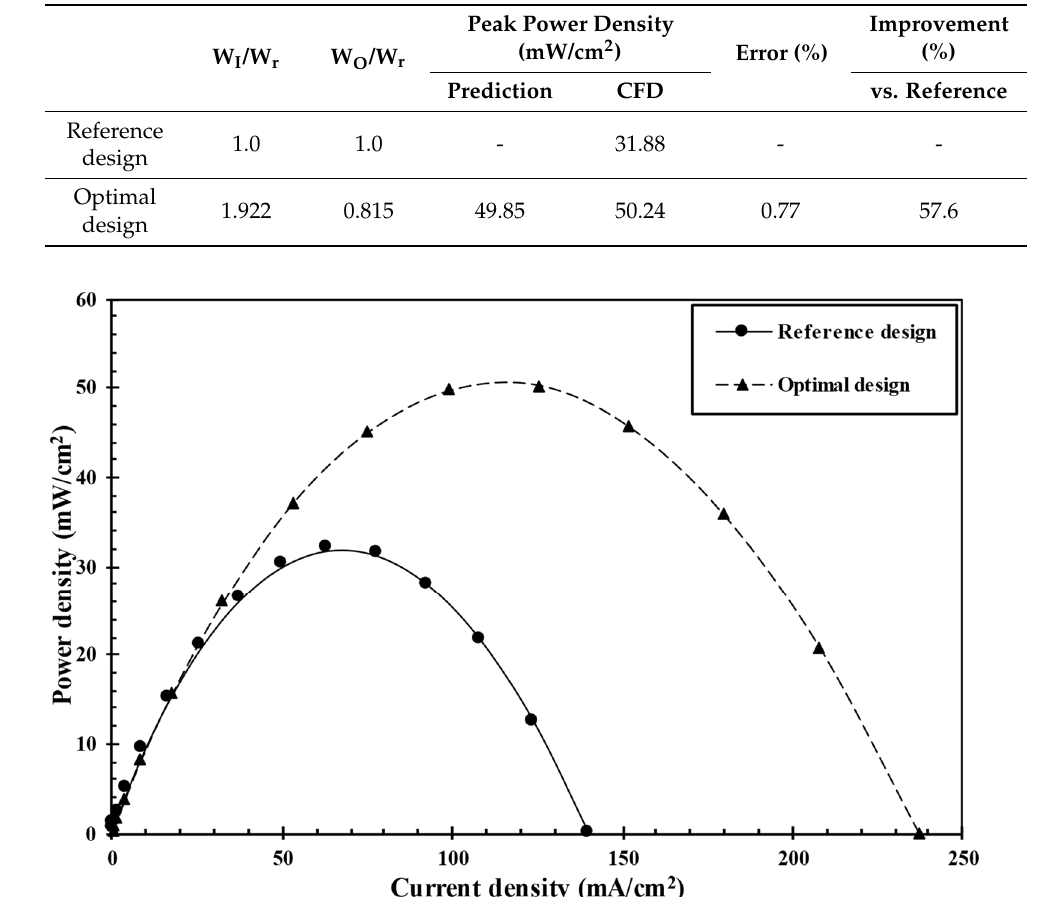
Table 6. Results of optimization.